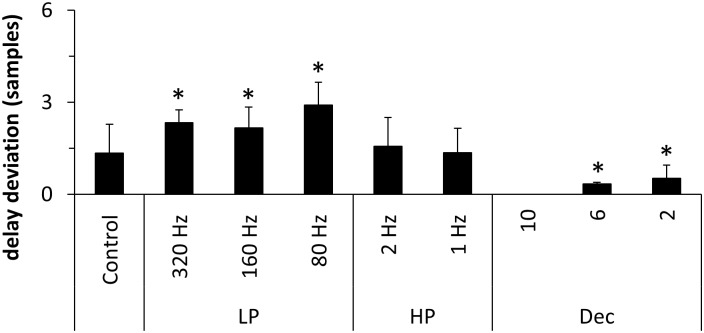
Delay deviation in samples for the Kus-model.LP: low-pass filter, HP: high-pass filter, Dec: decimation. Asterisks indicate results significantly different from control (Wilcoxon rank-sum test, p < = 0.05, Bonferroni corrected). Error bars indicate standard deviation (SD).